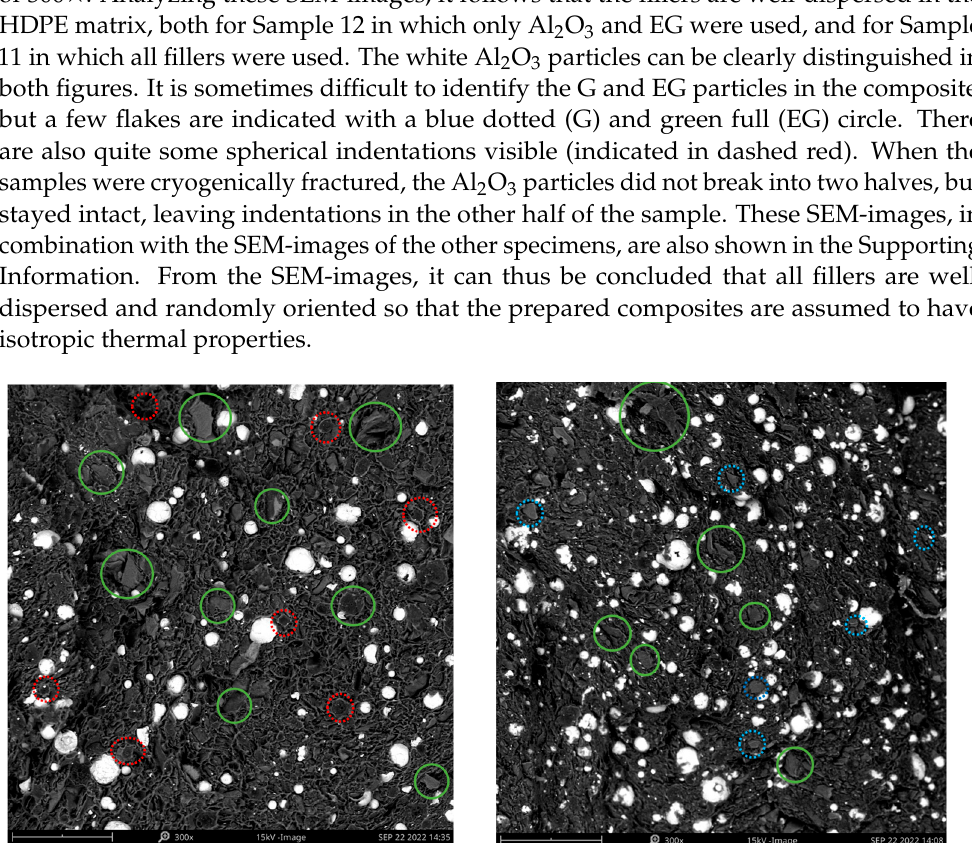
Figure 6. Schematic representation of the conductive paths (orange lines) in the HDPE hybrid filler system; the silver spheres represent the Al 2 O 3 particles, while the different platelet particles repre- sent the stacked layers of graphene; the big particles being EG and the small particles being G. From Figure 6, it can be seen that by using fillers with different size and shape, small filler particles can fill the gaps between bigger fillers. A good interconnectivity can there- fore be created between the fillers leading to a good conductive path (orange line) and optimal packing density. Moreover, the not-depicted CNTs serve as TC bridges to further improve the interconnection. It Is important to support the TC and SEM analysis via viscosity data, as illustrated in Table 4 for 15 compositions for an actual (wall) shear rate of 3 s − 1 . During compounding